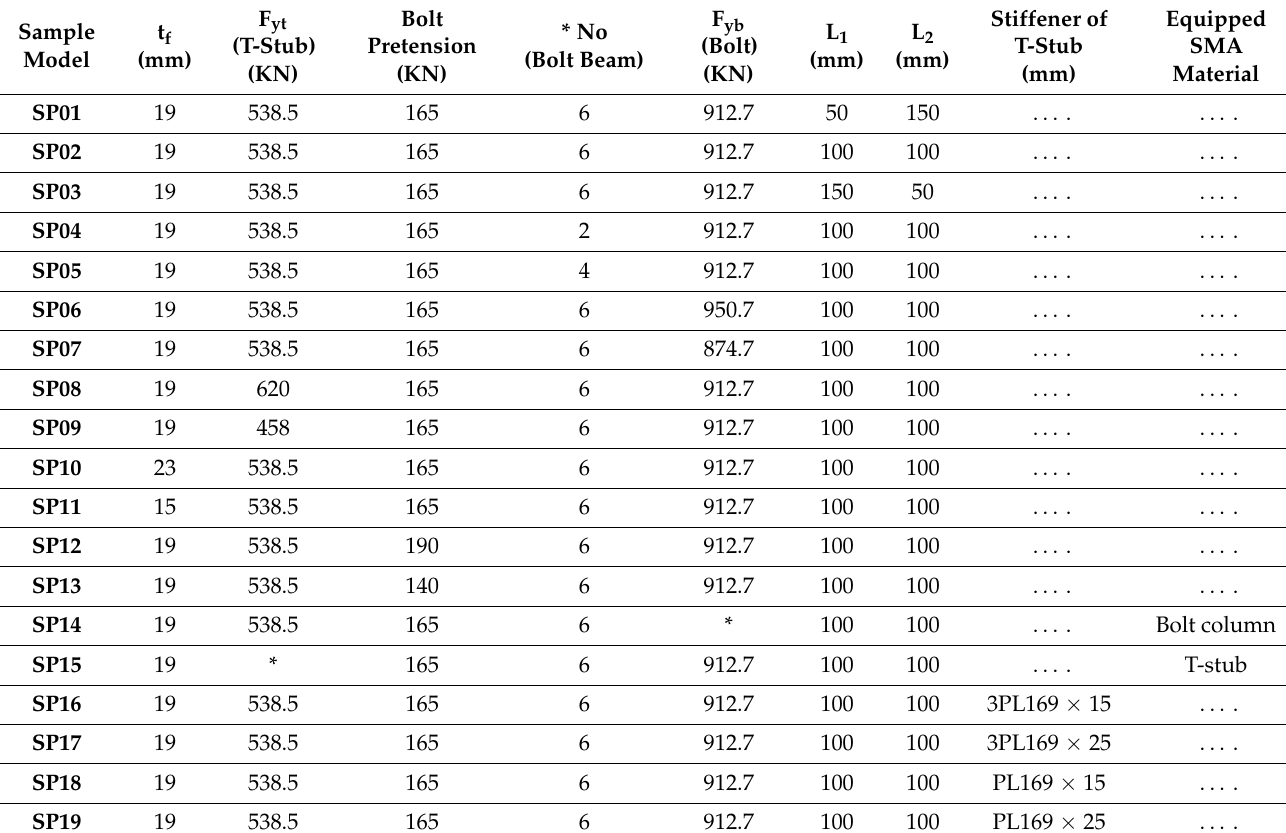
Table 3. Developed finite element models.